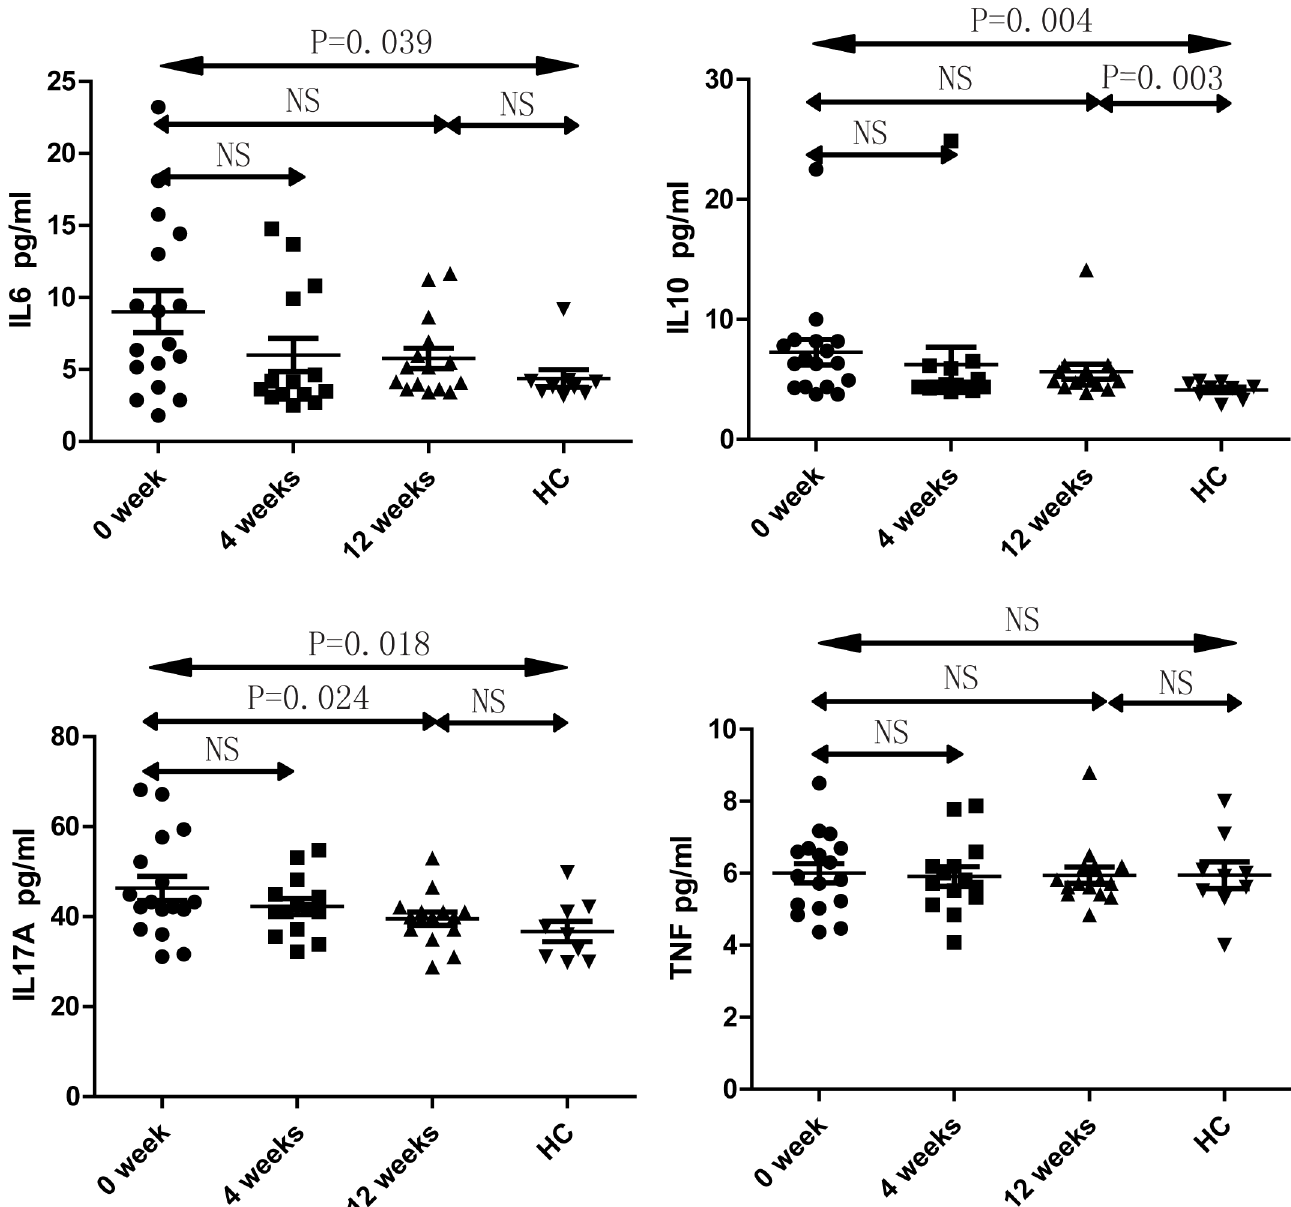
Fig 4. Cytokines profile in SLE patients The levels of serum IL-2, IL-4, IL-6, IL-10, IL-17A, IFN- γ and TNF- α in study participants was analyzed by CBA before and at 4 weeks and 12 weeks after initiation of